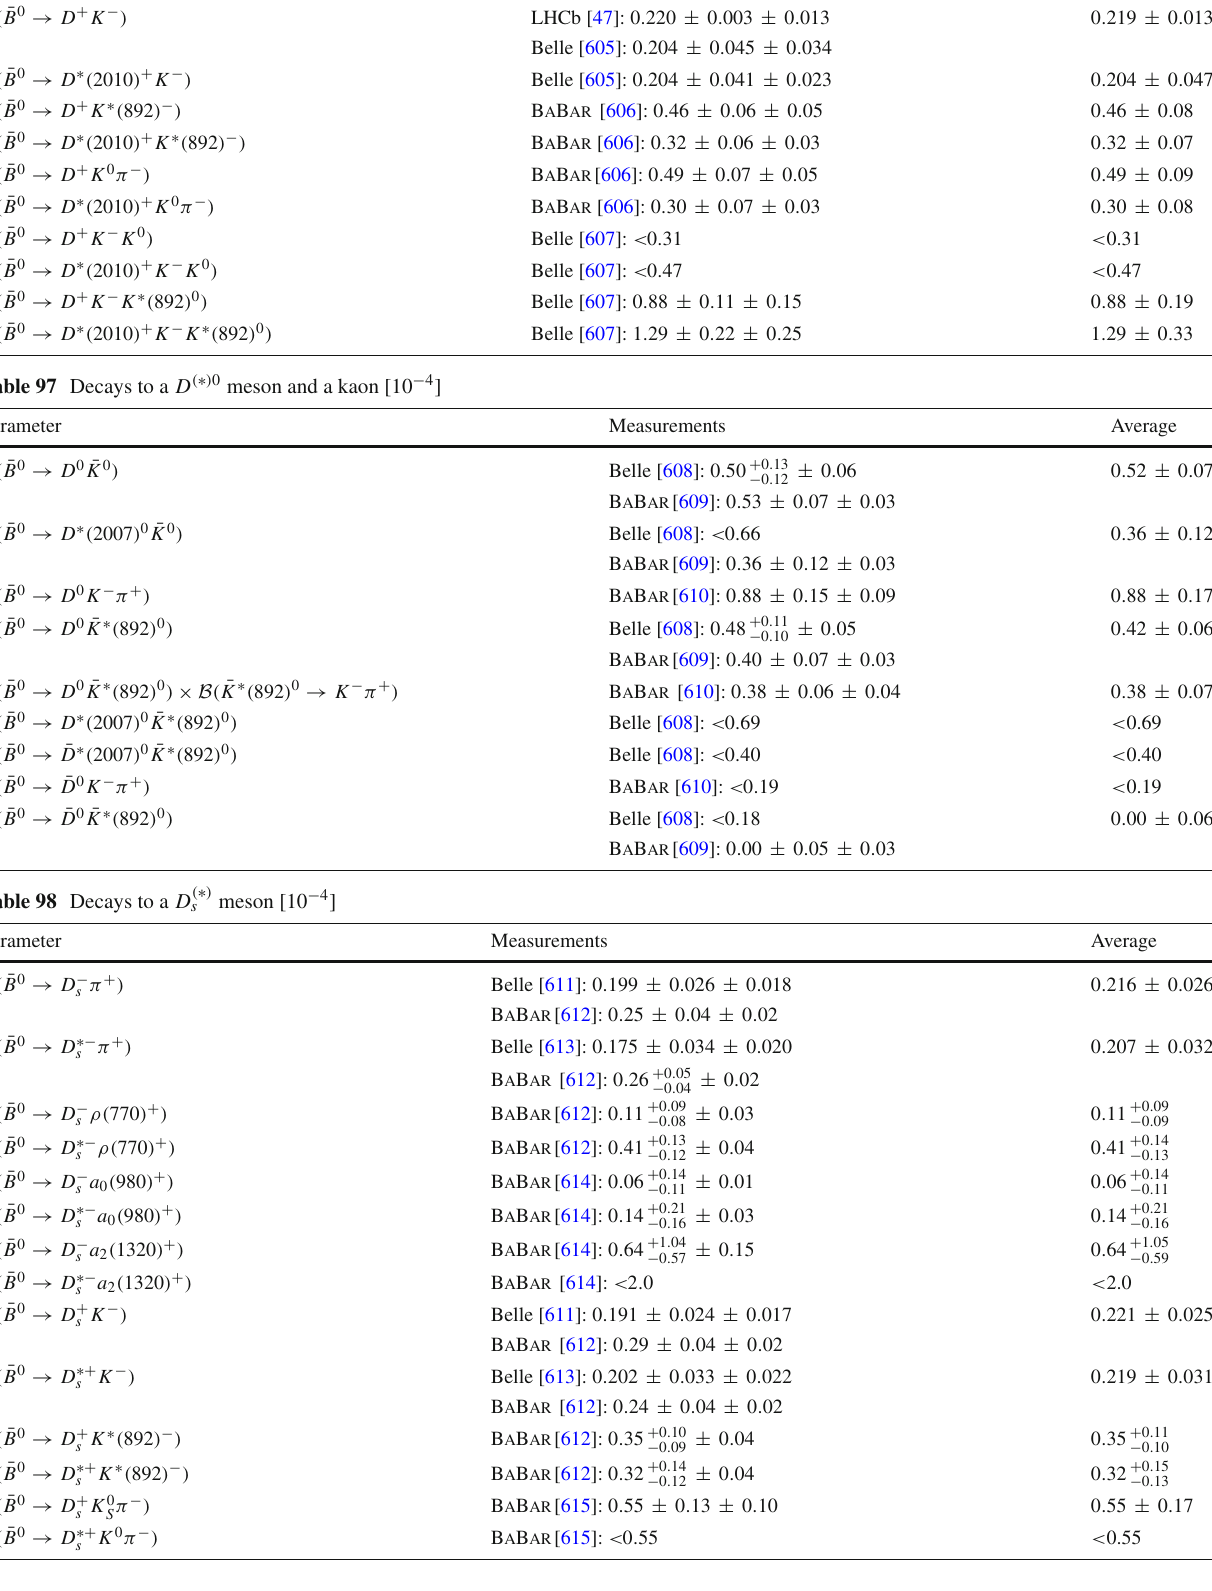
Table 96 Decays to a D ( ∗ ) + meson and one or more kaons [ 10 − 3 ] Parameter